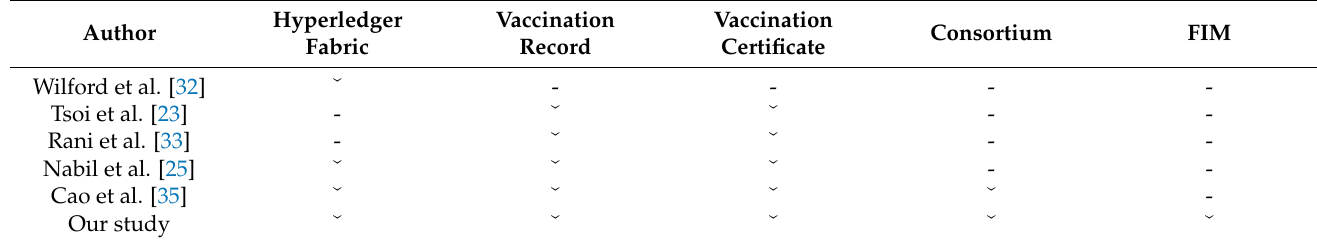
Table 2. Comparison of Hyperledger Fabric researches in digital vaccine